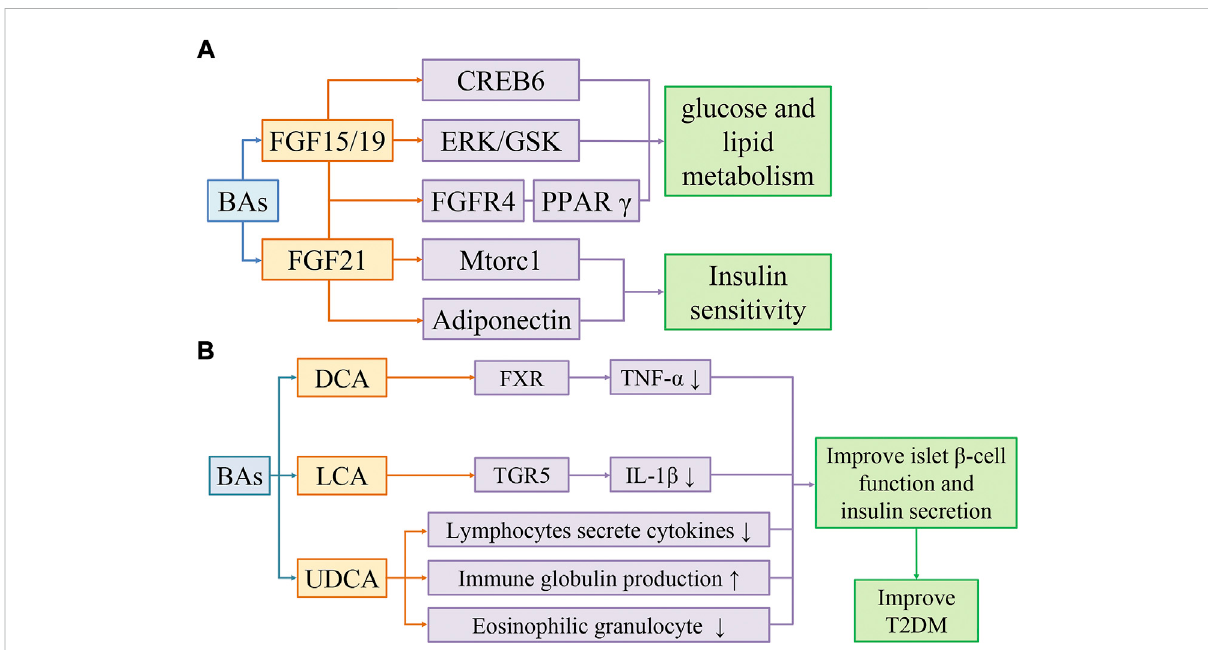
FIGURE 2 Bile acids activate FGF15/19 and FGF21 pathways to improve insulin sensitivity (A) . Bile acids improve T2DM by reducing in fl ammation (B) . (A) BAs improve glucose and lipid metabolism through FGF19/CREB6, FGF19/EPK/GSK, and FGF19/FGFR4/PPAR γ pathways, and improve insulin sensitivity through FGF21/Mtorc1 and FGF21/Adiponectin pathways. (B) DCA activates FXR to reduce TNF- α levels. LCA activates TGR5 to reduce IL- 1 β levels. UDCA regulates the immune system by reducing cytokine secretion by lymphocytes, producing immunoglobulins, and inhibiting eosinophil activation and degranulation. Secondary bile acids can improve T2DM by restoring islet β -cell function and insulin secretion affected by in fl